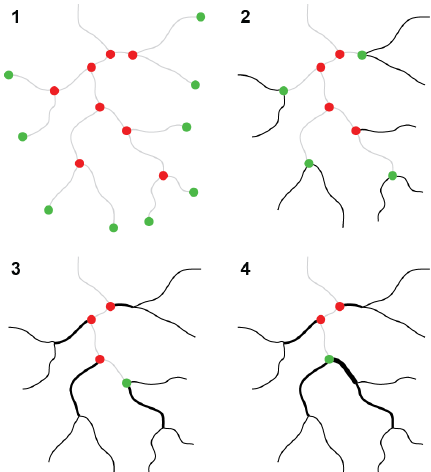
Figure 4. Iterative sorting and ordering of the divide network. The divide network is assembled starting with divide segments that con- tain endpoints (green) and which are then removed from the collec- tion of divide segments. Former junctions (red) that have only one segment remaining become endpoints, and the iteration continues until no more endpoints